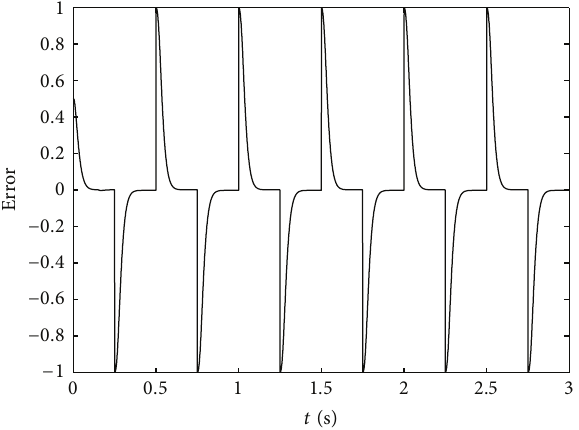
Figure 4: Output error curve of compound